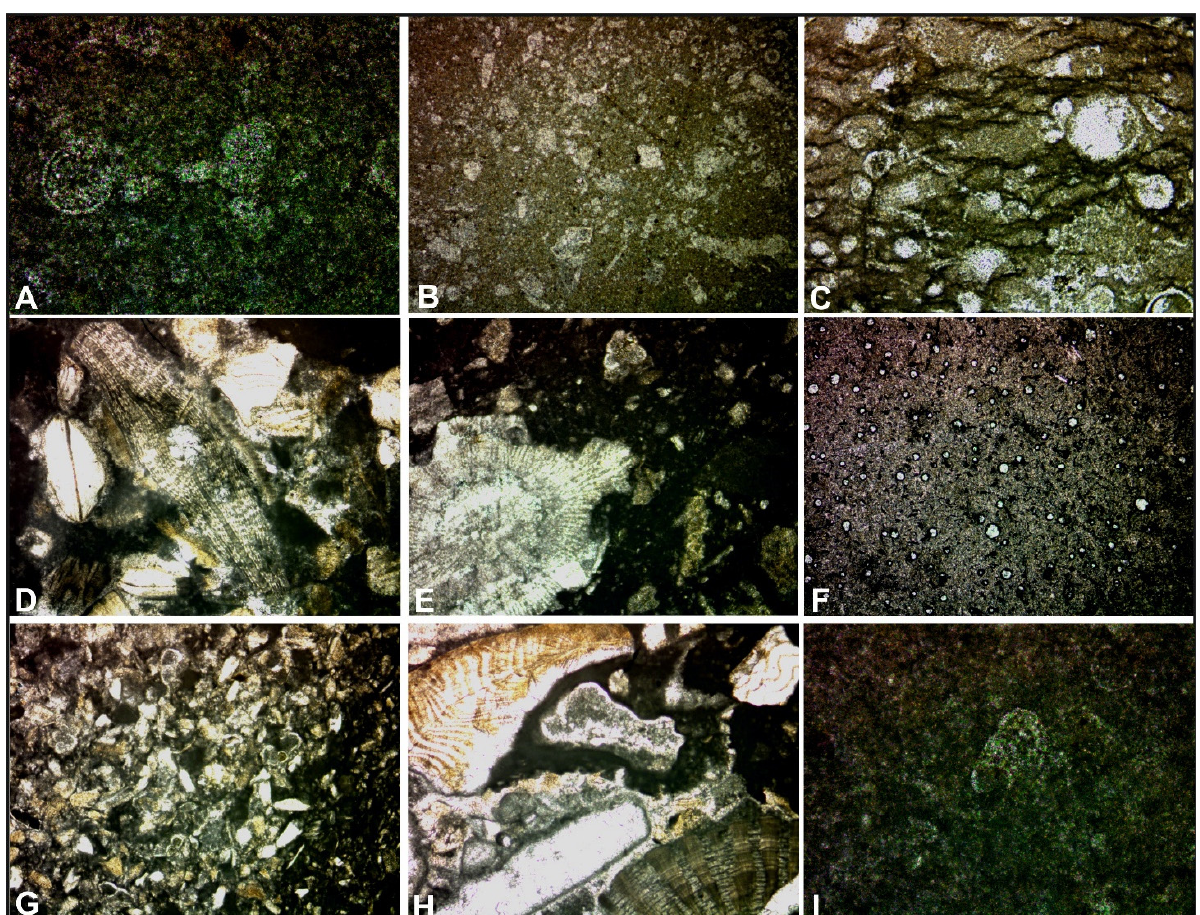
Figure 6. ( A ) AP29 sample of Upper Cretaceous (Maastrichtian): wackestone with Alanlordella bentonensis ( X 400), ( B ) AP32 sample of Upper Cretaceous (Maastrichtian): wackestone with Globotruncana arca ( X 40), ( C ) AP9 sample of Lower Cretaceous (Albian): numerus Radiolarian specimens ( X 400), ( D ) AP19 sample of Upper Cretaceous (Campanian-Maastrichtian): packstone with Lepidorbitoides sp. ( X 40), ( E ) AP29 sample of Upper Cretaceous (Maastrichtian): Siderolites calcitrapoides ( X 40), ( F ) AP6 sample of Lower Cretaceous: wackestone with numerous Radiolarian tests ( X 40), ( G ) AP27 sample of Upper Cretaceous (Maastrichtian): packstone with planktonic foraminifera (Abathomphalus mayaroensis, X 40), ( H ) AP26 sample of Upper Cretaceous (Campanian-Maastrichtian): Orbitoides sp., rudists fragments ( X 40), ( I ) Blefuscuiana gorbachicae ( X 400).